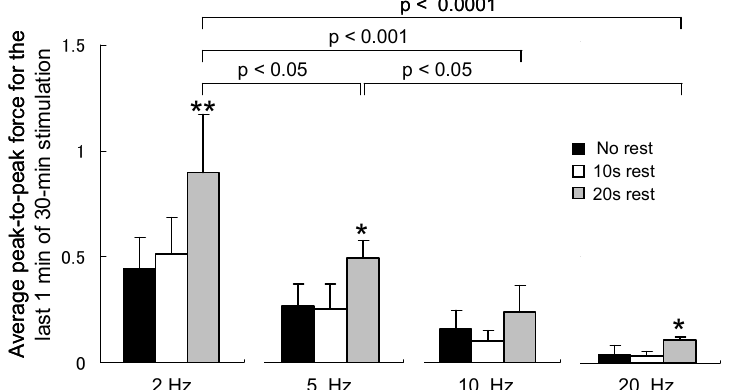
Fig. 7 Comparison of peak-to-peak contraction forces averaged for the last 1 min of the 30-min stimulation among all the combinations of stimulation frequency and resting time. Each peak-to-peak force was normalized to the 1st peak force before the averaging. Symbols: *p < 0.05 and **p< 0.01 vs. no-rest group in the same frequency.